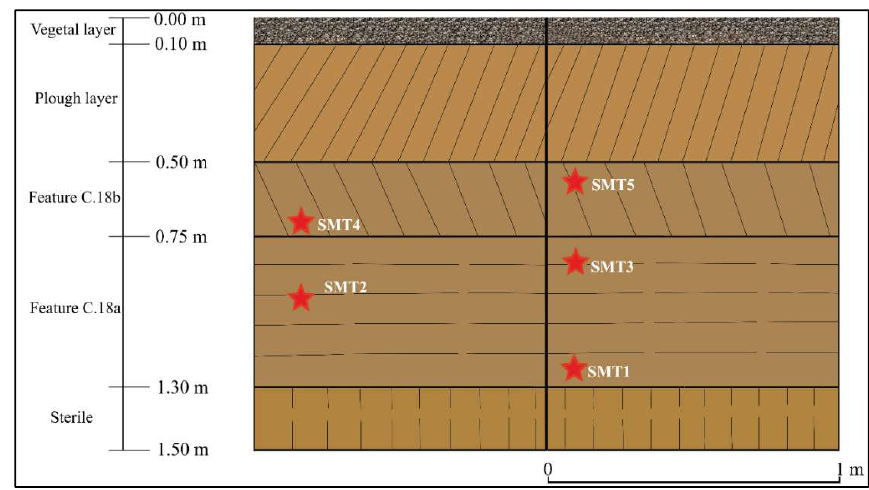
Figure 4. Location of the sediment samples (SMT 1–5) in the cultural layers.